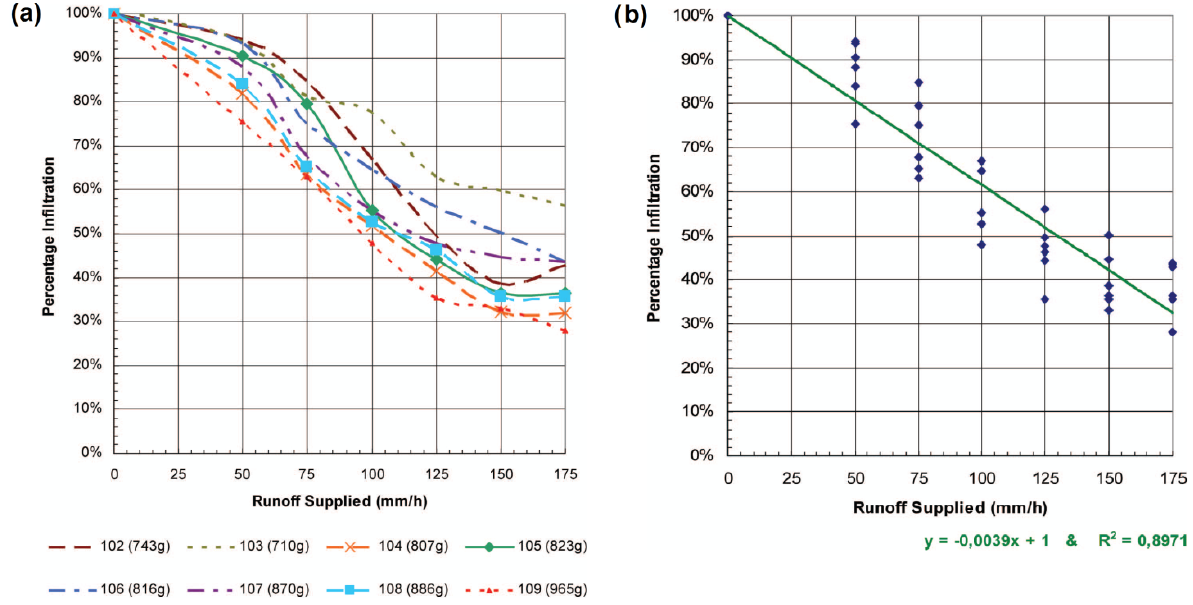
Figure 3. Evolution of permeability in ICBP surface obtained with CFI: ( a ) Runoff resistance results; ( b ) Linear regression model